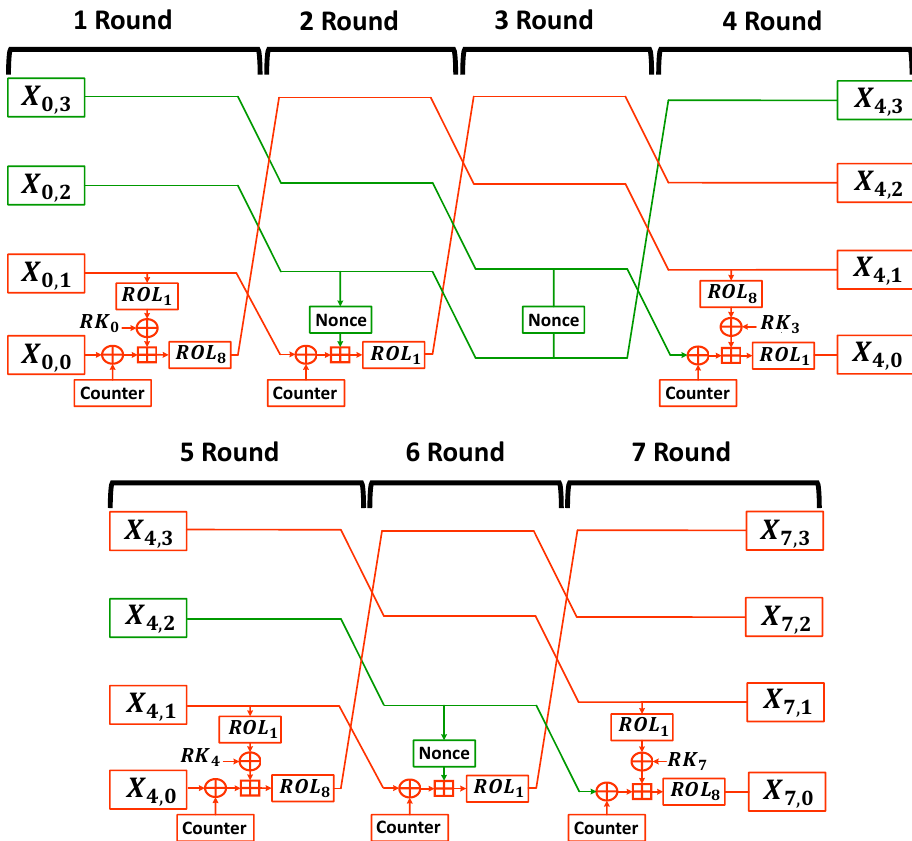
Figure 5. Optimization of revised CHAM-64/128-CTR mode through partial pre-computation for the initial seven rounds in previous work